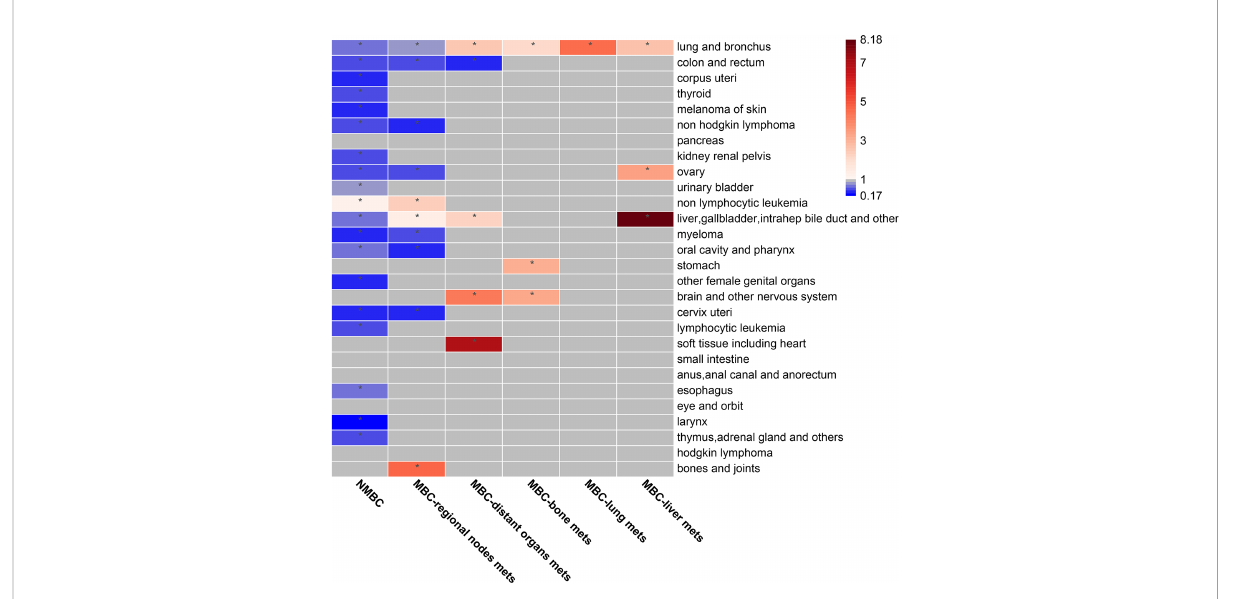
FIGURE 4 The standard mortality rate (SMR) of SPCs in BC patients with different metastasis status. The SMR is calculated as the ratio of observed SPC deaths to the expected number of cancer deaths in the general population. The cells marked with an * symbol indicate statistically signi fi cant association between fi rst primary breast cancer (BC) and SPCs. Blue cells indicate SMRs that are statistically signi fi cantly lower than expected according to a qualifying statistical test (number of SPCs observed ≥ 5). Red cells indicate SMRs that are statistically signi fi cantly higher than expected according to a qualifying statistical test (number of SPCs observed ≥ 5). Grey cells indicate SMRs that are not statistically signi fi cant, or no association was tested due to the small number of SPCs observed. Point estimates and 95% CIs are shown in Supplementary Table